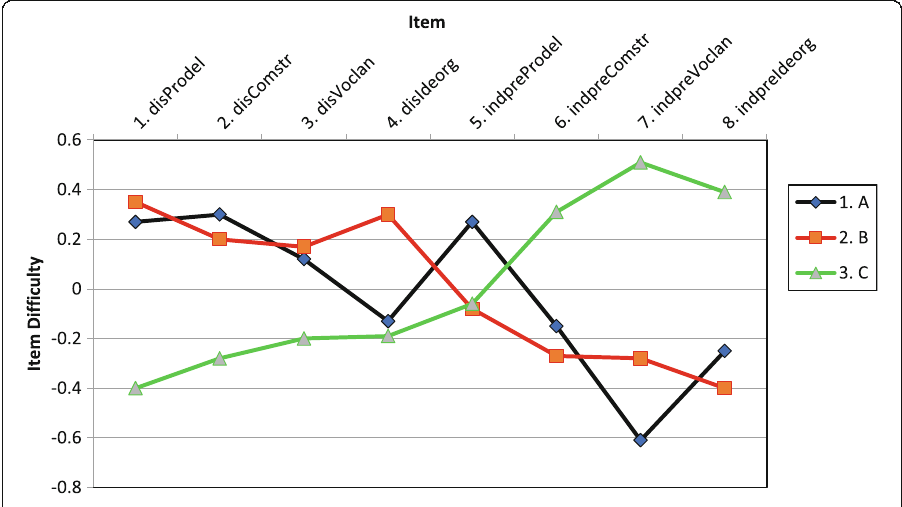
Fig. 2 Relative item difficulty for the three